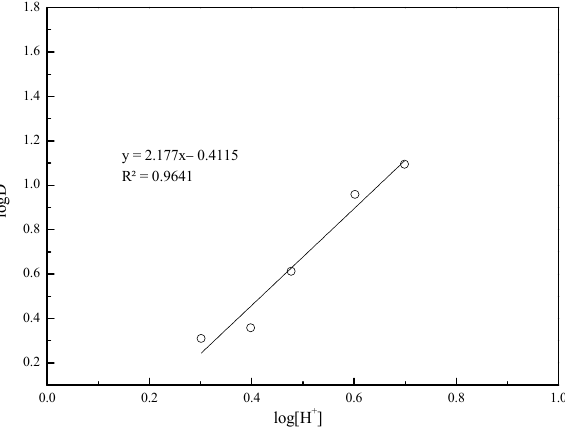
Figure 7. A plot of logD versus log[H + ] for the extraction of Cu with TOPO. 3.2.2. The Effect of TOPO Concentration on the Extraction of Metal Ions Effect of TOPO concentration on the extraction of metals was investigated by varying the TOPO concentration in the extractant from 0.1 to 1 mol/L. The concentration of HCl in the feed solution was maintained at 3 mol/L, and the metal ion concentrations were the same as those in the leachate (Section 3.1.3). The results indicate that the extraction percentage of Cu increased sharply from 2.4 to 85.1% while leaving the other metal ions in the raffinate by increasing the concentration of TOPO from 0.1 to 1 mol/L. The extraction percentages of the other metal ions were ~0% and did not change with varying of the TOPO concentration. The results of extracting Cu with TOPO are presented as a logD versus log[TOPO] plot in Figure 8; the slope is 2.4046 which suggests that two TOPO molecules are associated with the extracted Cu species.